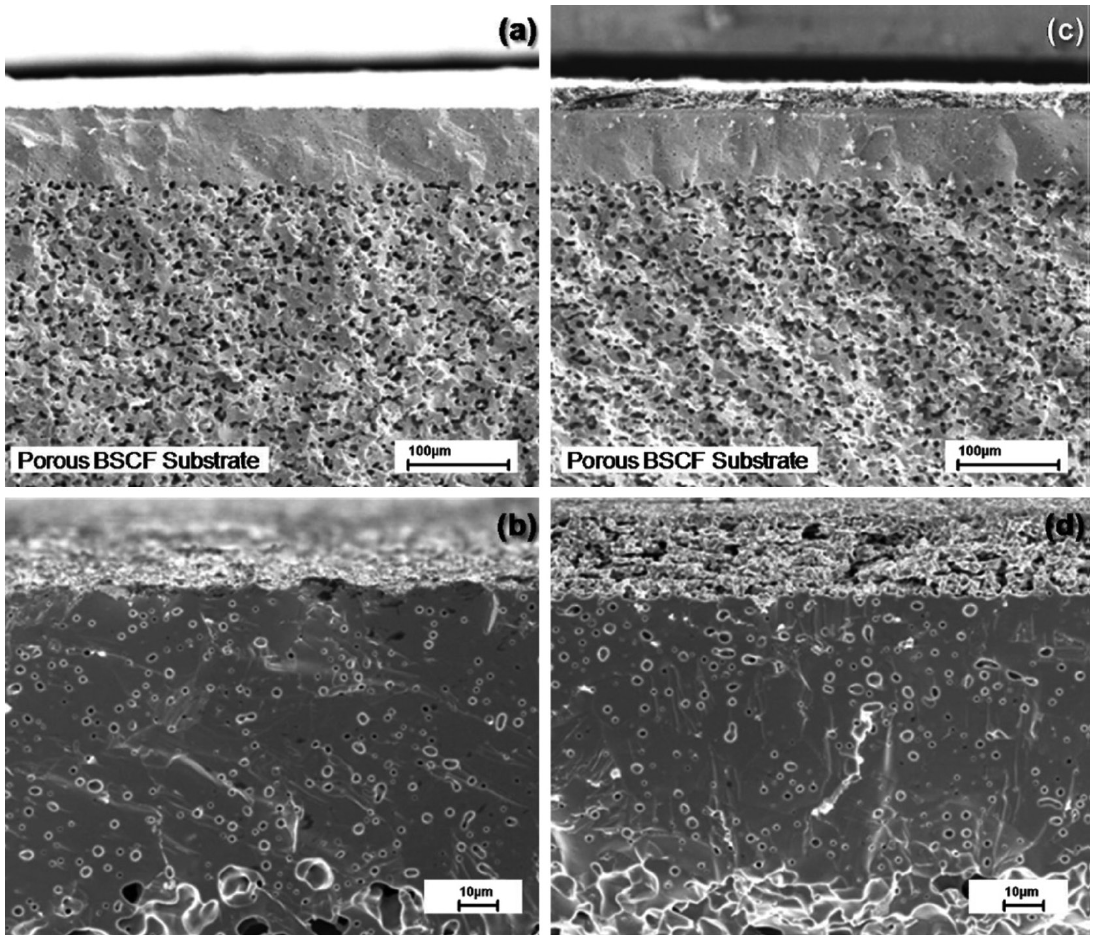
Figure 4. Fracture cross-sections (SEM images) of two membranes after oxygen permeation measurements: (a and b) without oxygen activity layer and (c and d) with an oxygen activation layer 20